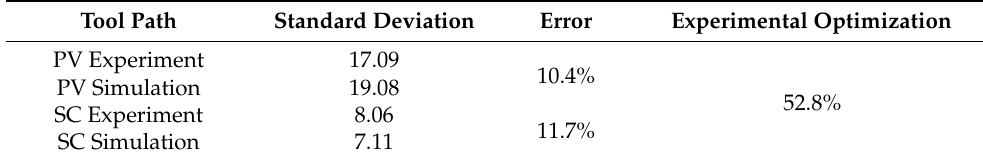
Table 2. Simulation and experiment comparison table.